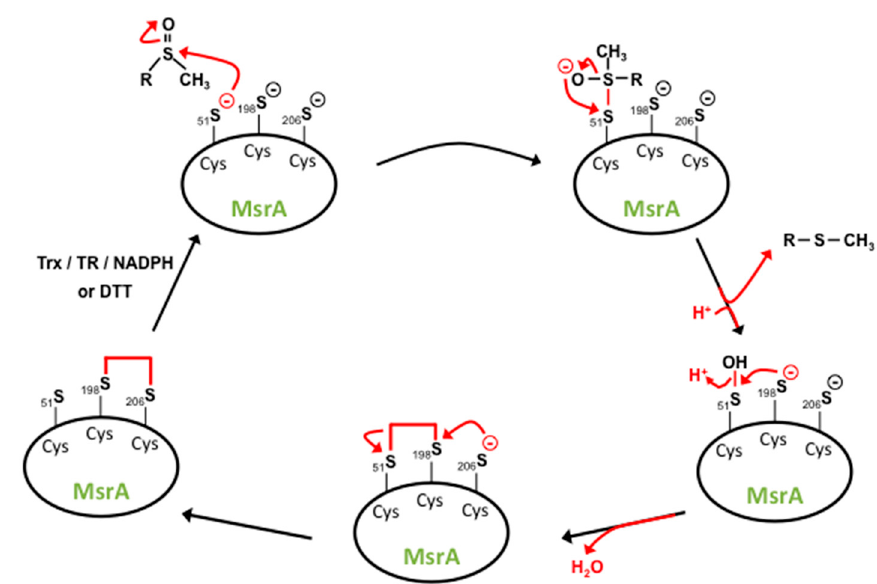
Figure 4. MsrA catalytic mechanism. The nucleophilic attack of the MsrA catalytic cystein (Cys)-51 on the sulfur atom of the methionine sulfoxide substrate leads to the formation of an unstable intermediate (enzyme bound to the substrate). Bacterial MsrA is used in this representation. Ionic rearrangement leads to the formation of a sulfenate ion with the concomitant release of the methionine molecule and protonation of the sulfenate ion to produce a sulfenic acid intermediate on MsrA. The nucleophilic attack of the recycling Cys-198 on the sulfur atom of the sulfenic acid intermediate leads to the formation of an intramolecular disulfide bond. MsrA full native state recovery is achieved after another nucleophilic attack of Cys-198 on Cys-206 generating a second intramolecular disulfide bond, which can be reduced either by the thioredoxin (Trx)/thioredoxin reductase (TR)/NADPH regenerating system or by dithiothreitol (DTT) [60,63].